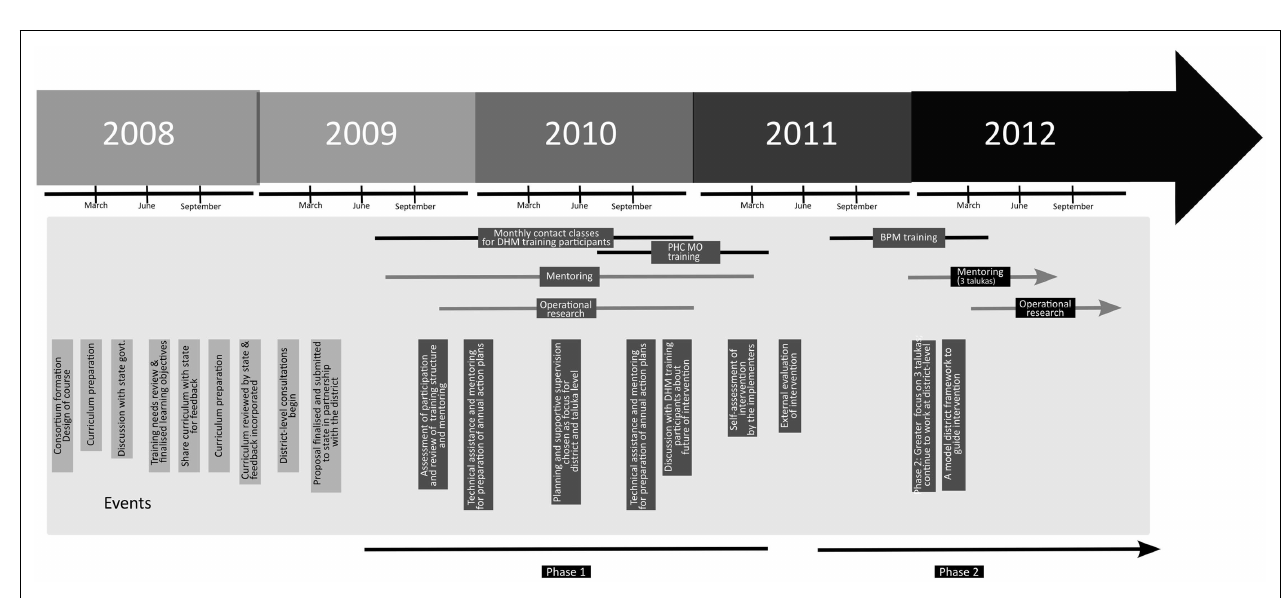
FIGURE 5 | Key events in course of the capacity-building intervention